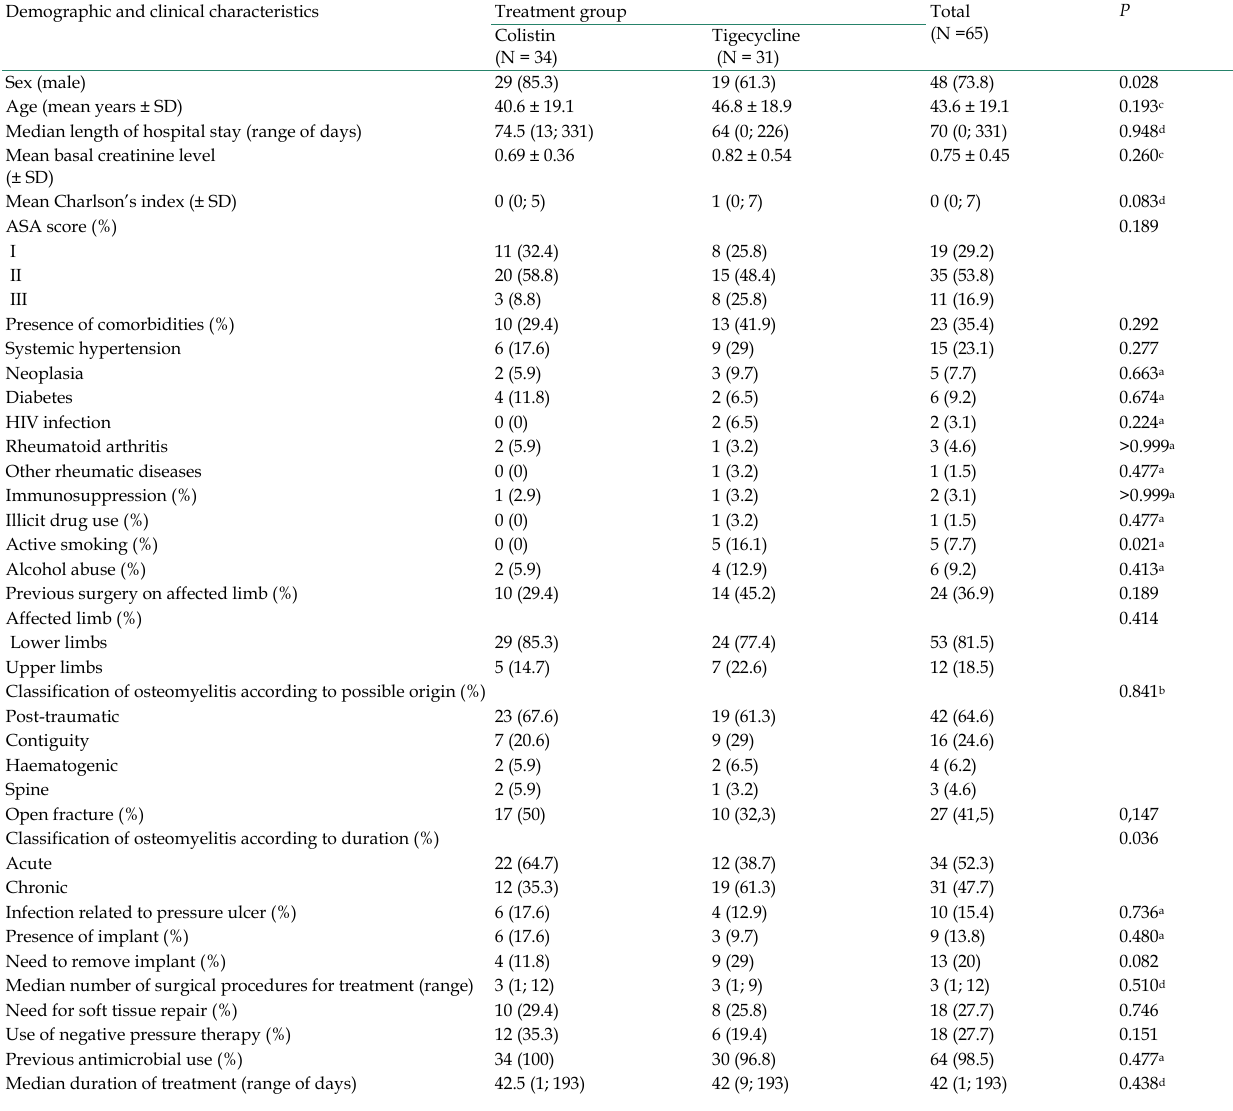
Table 1. Distribution of patients with carbapenem-resistant A. baumannii complex osteomyelitis according to demographic and clinical characteristics and comparison according to treatment group (colistin or tigecycline) Demographic and clinical